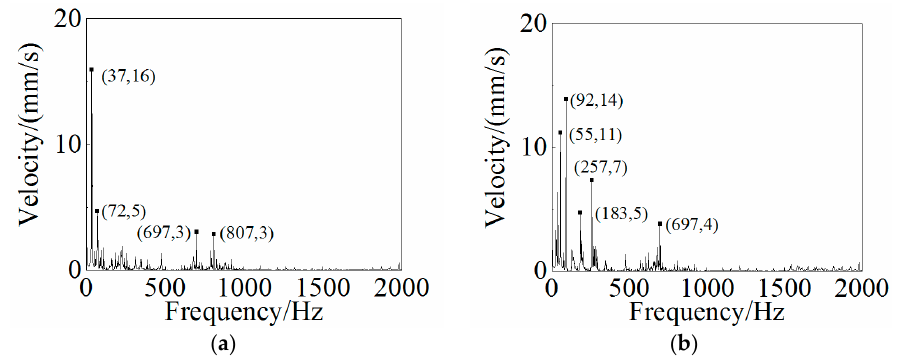
Figure 23. Frequency responses of ( a ) the isotropic and ( b ) the orthotropic oil cooler covers at Point 3 of Figure 20.